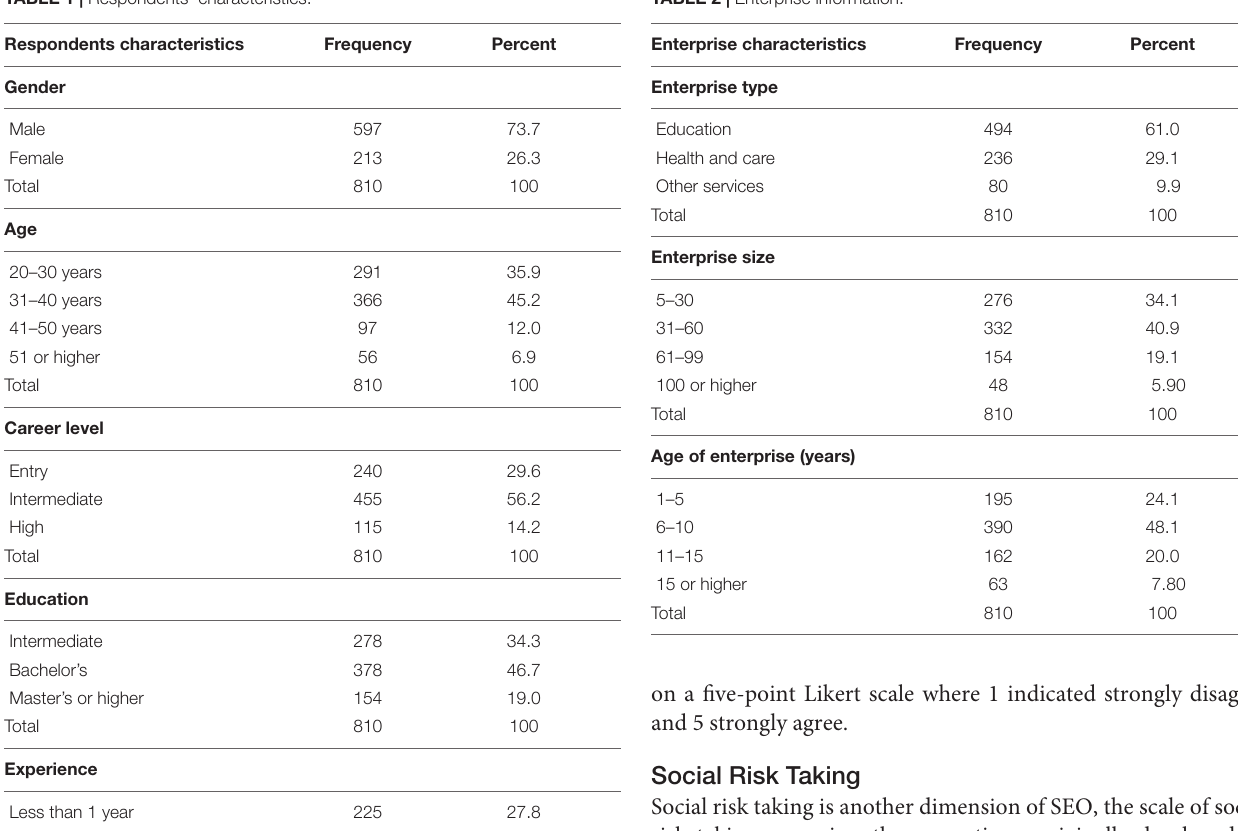
TABLE 1 | Respondents’